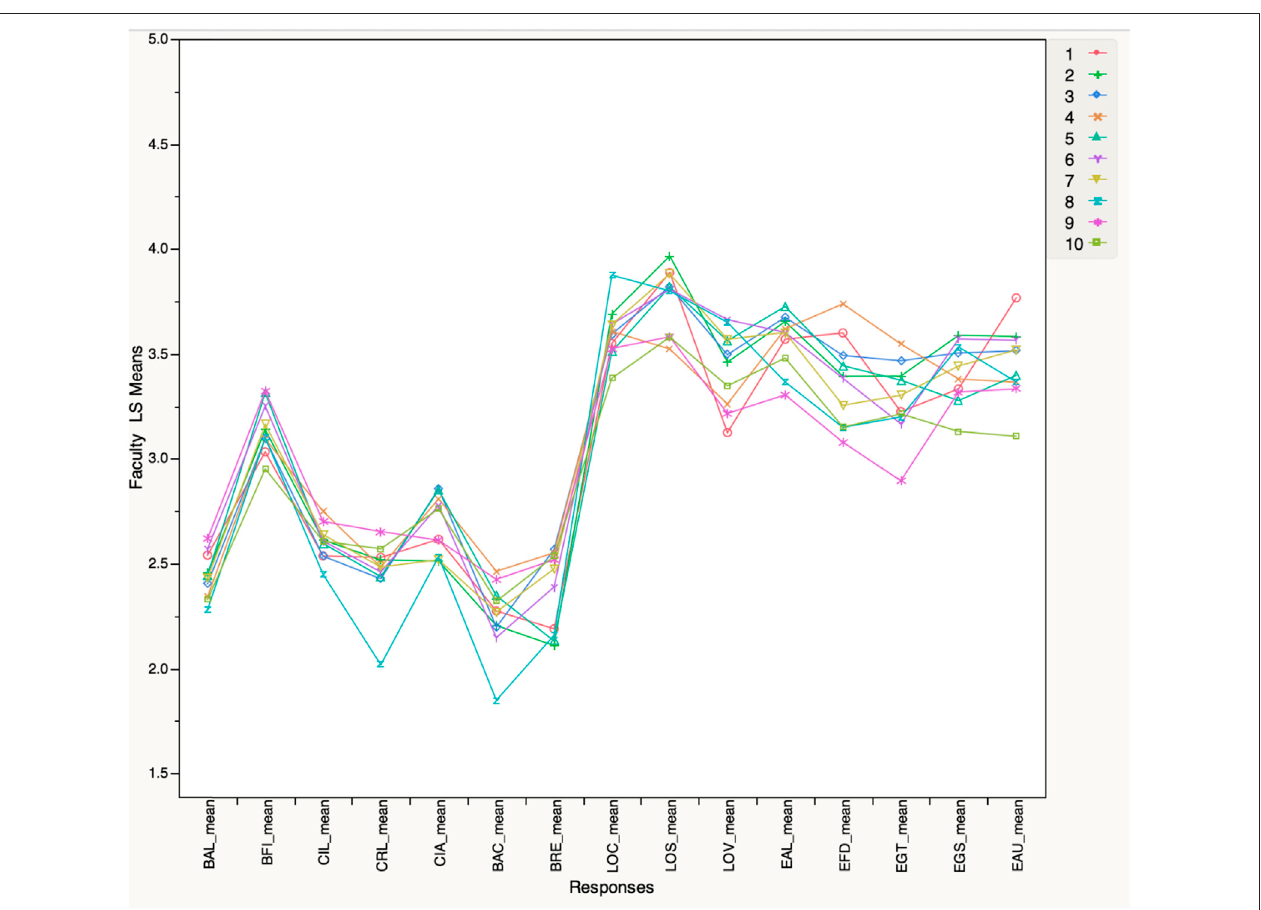
FIGURE1| Facultydifferencesacrossthe14 fi nalisedconstructs. Notes: SLEQ: EAUAssessmentforunderstanding;EGSClearGoals;EFDFeedback;EALActive Learning; LOV Value (Learning Outcomes); LOS Social (Learning Outcomes); LOC Cognitive (Learning Outcomes). CCSS: BAL Active/collaborative learning; BFI Student-Faculty Interaction; CIL Integrated Learning (Cognitive Engagement); CRL Re fl ective Learning (Cognitive Engagement); CIA Information Analysis (Cognitive Engagement); BRE Richness Of educational experience; BAC Academic Challenge. 1) Architecture 2) Business-Economics 3) Arts 4) Dentistry 5) Education 6) Social Sciences 7) Science 8) Law 9) Engineering 10)